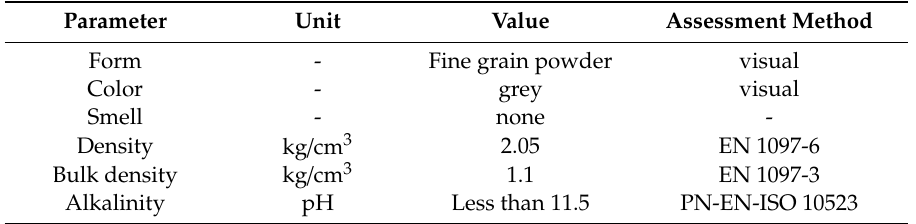
Table 4. Basic properties of fly